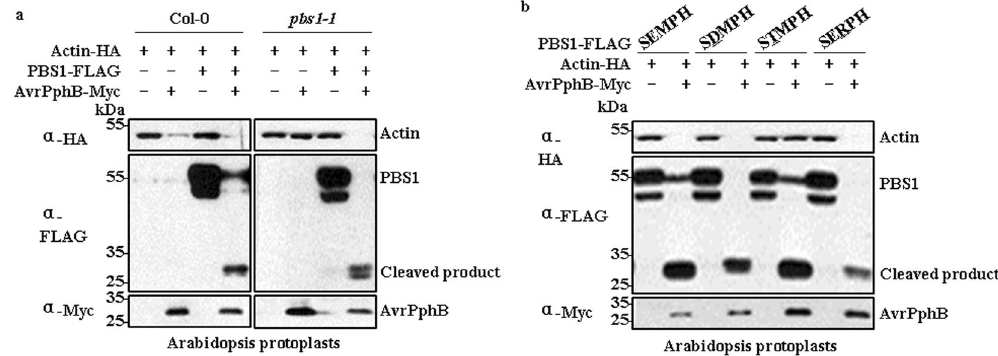
Figure 7. A negatively charged amino acid at the position of “E” in the SEMPH motif is required for recognition of PBS1 by RPS5. ( a ) Development of an AvrPphB-induced PCD assay system in pbs1 protoplasts. AvrPphB was co-expressed together with PBS1 and Actin-HA in Arabidopsis mesophyll protoplasts isolated from pbs1 plants. The PCD induced in Arabidopsis mesophyll protoplasts was monitored by the repression of Actin-HA expression. ( b ) A negatively charged amino acid at the position of “E” in the SEMPH motif is required for recognition of PBS1 by RPS5, while the amino acid “M” may not be essential for the recognition. Three PBS1 mutants were generated with either “E” or “M” mutated. Then each PBS1 mutant was expressed together with AvrPphB and Actin-HA in pbs1